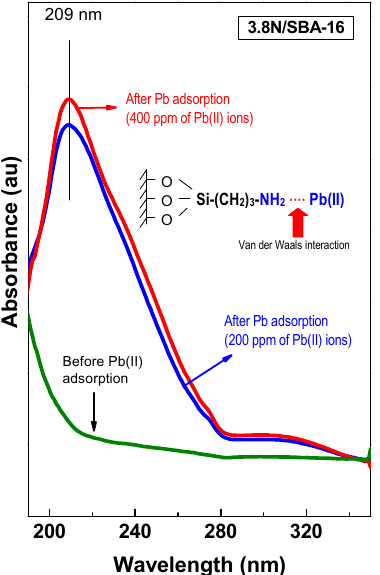
Figure 6. UV-vis spectra for the 3.8N/SBA-16 adsorbent after adsorption (initial Pb 2+ concentrations in aqueous solution: 200 and 400 mg L − 1 ). The scheme of the proposed van der Walls interaction of Pb 2+ with amino group [1] is shown in the inlet of this figure.